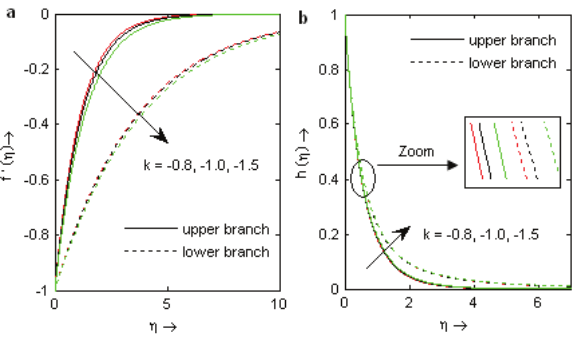
Figure 3. (a) Dual velocity profiles f 0 .(cid:17)/ and (b) Dual tem- perature profiles h ( (cid:17)/ for various values of k with s D 2,